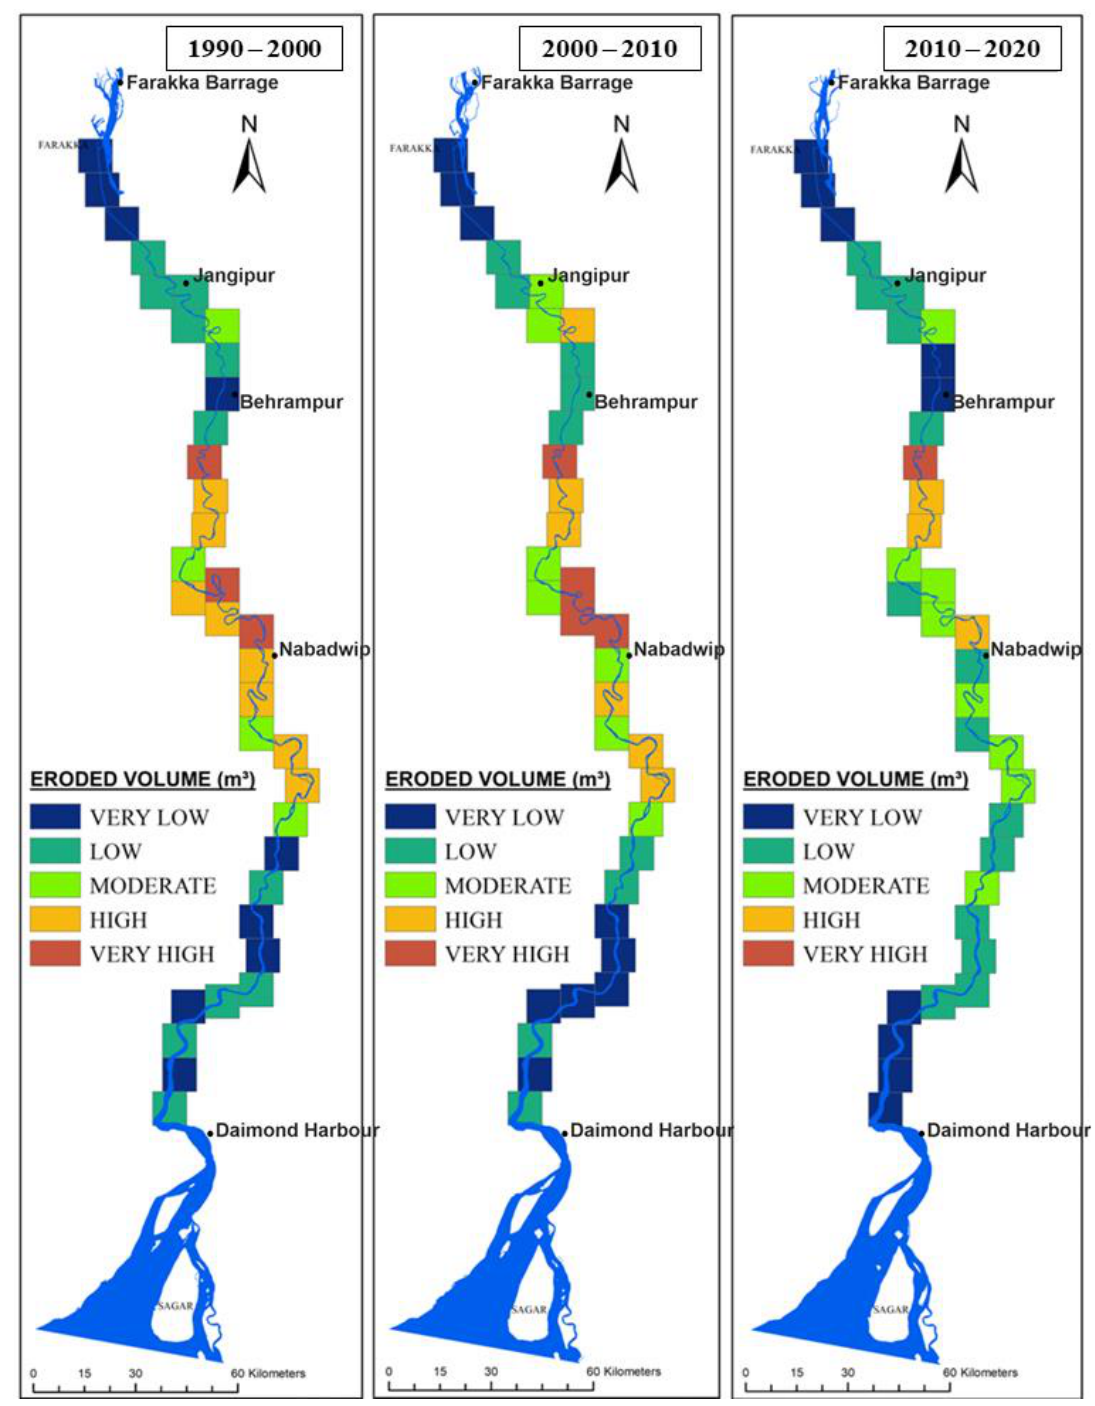
Figure 5. Eroded volume zones along the Bhagirathi - Hugli River during selected periods.